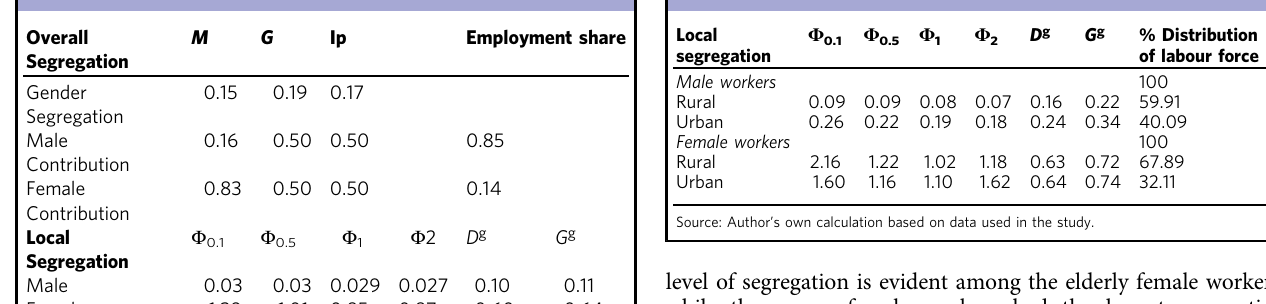
Table 5 Occupational gender segregation by region. Table 4 Occupational segregation by